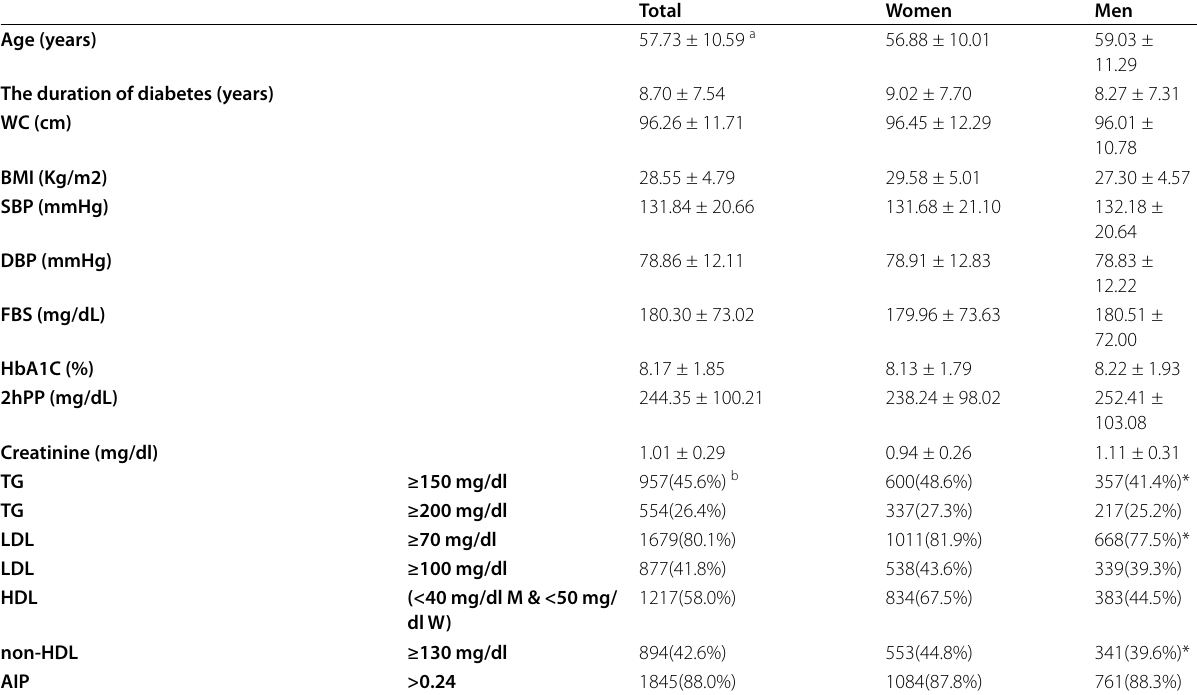
Table 1 Baseline characteristics of patients